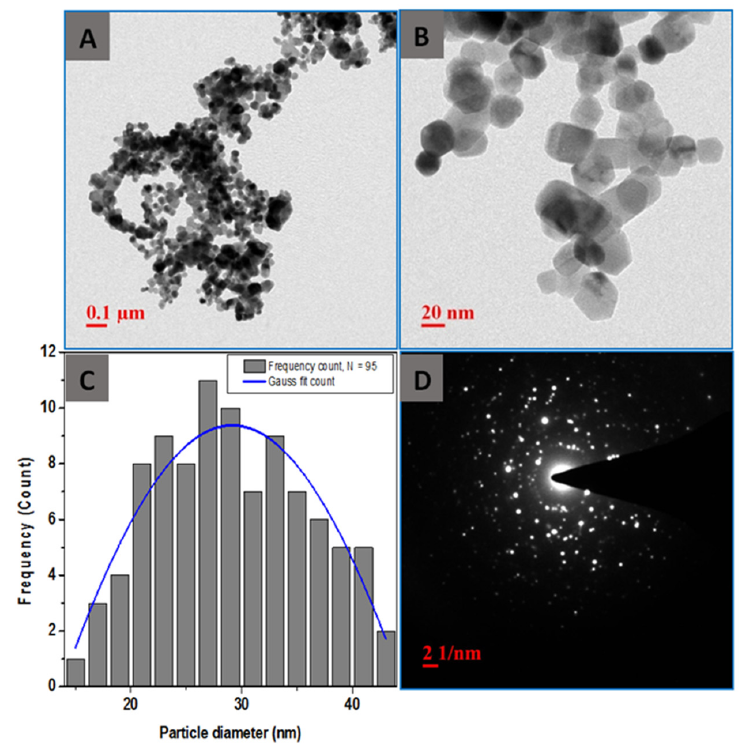
Figure 2. Transmission electron microscope (TEM) analysis of the as-synthesized ZnO NPs ( A ) showing the distribution of nanoparticles, ( B ) at a higher magnification showing the variation of particle sizes, ( C ) particle size distribution determined from 95 particles, and ( D ) selected area (electron) di ff raction (SAED) pattern showing the